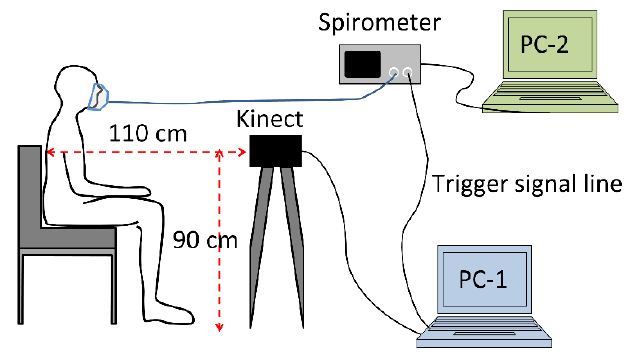
Figure 1. System configuration.